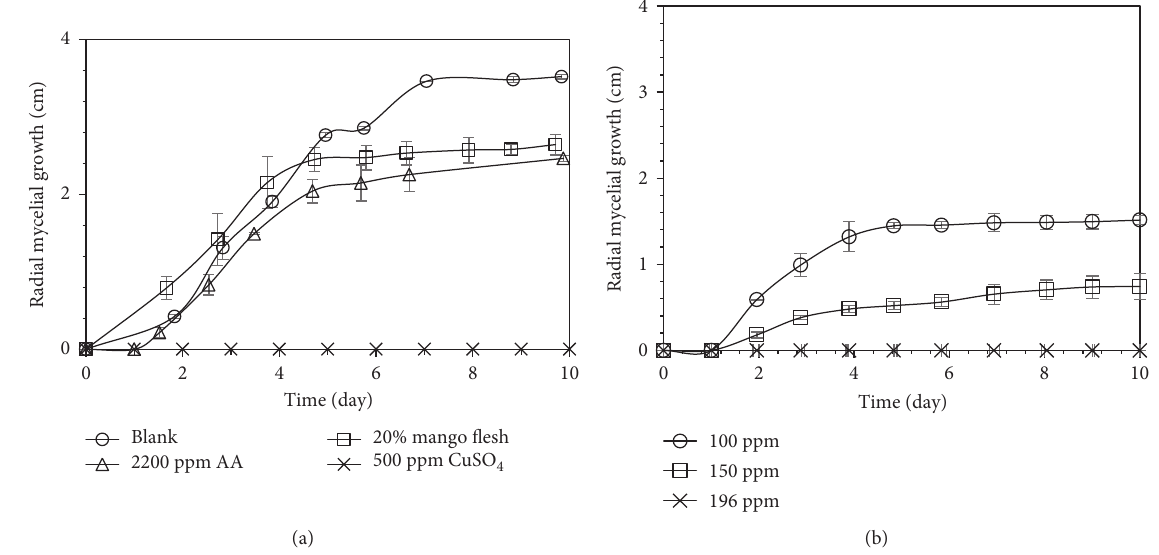
Figure 8: Growth dynamics of C. gloeosporioides on control media (a) and CuNPs-containing media